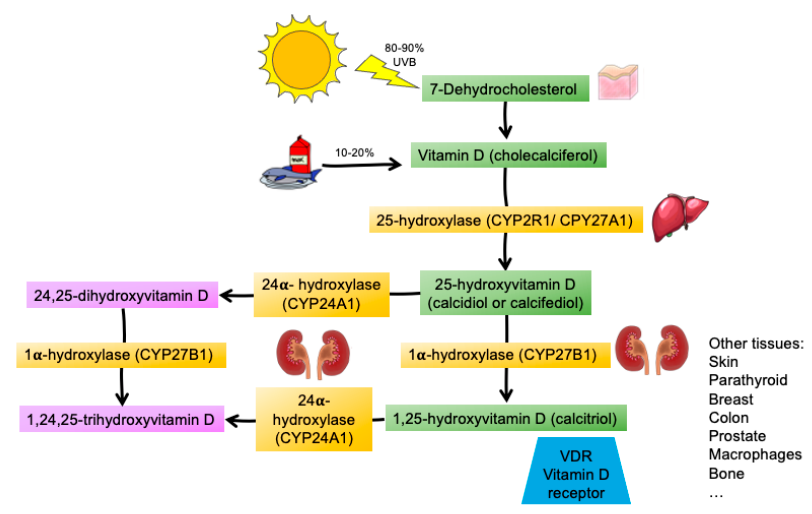
Figure 1. The vitamin D endocrine system metabolism.